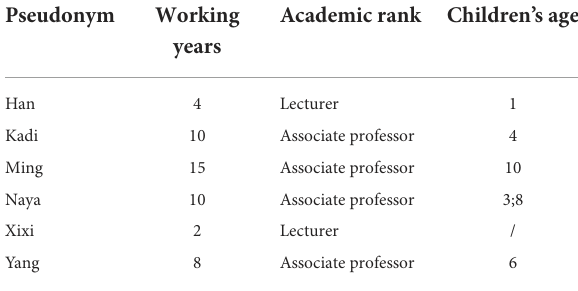
TABLE 1 Biographical information of the